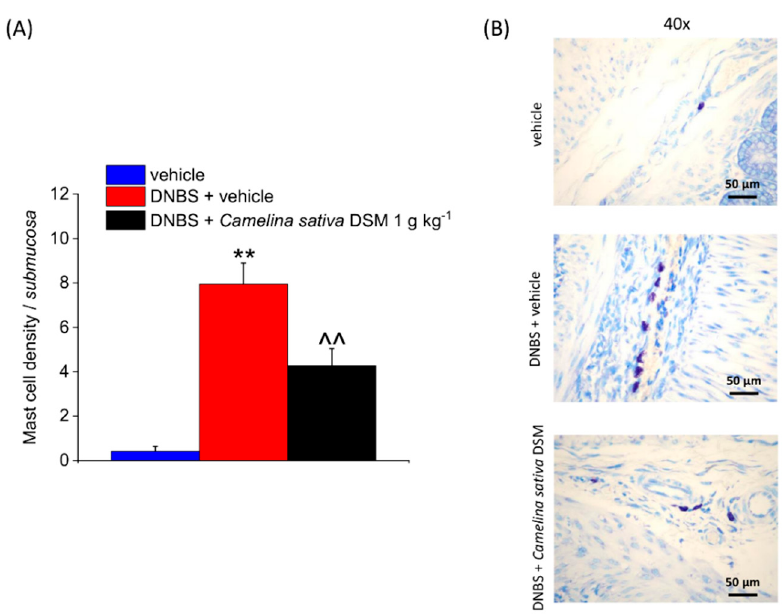
Figure 7. The effects of the repeated treatment with Camelina sativa DSM on submucosal mast cell infiltration caused by DNBS. Camelina sativa DSM (1 g kg − 1 ) was administered once daily in the DNBS-treated animals, starting from the day of DNBS injection for 14 consecutive days, and then tissues were collected. The column graph displays the mean mast cell density per area of colonic wall (cells/field) ( A ). The panel shows pictures captured from submucosa of mast cell granules stained in purple with GIEMSA ( B ). Each value represents the mean ± SEM of six animals per group. ** p < 0.01 vs. vehicle. ˆˆ p < 0.01 vs. DNBS. Original magnification: 40 ×